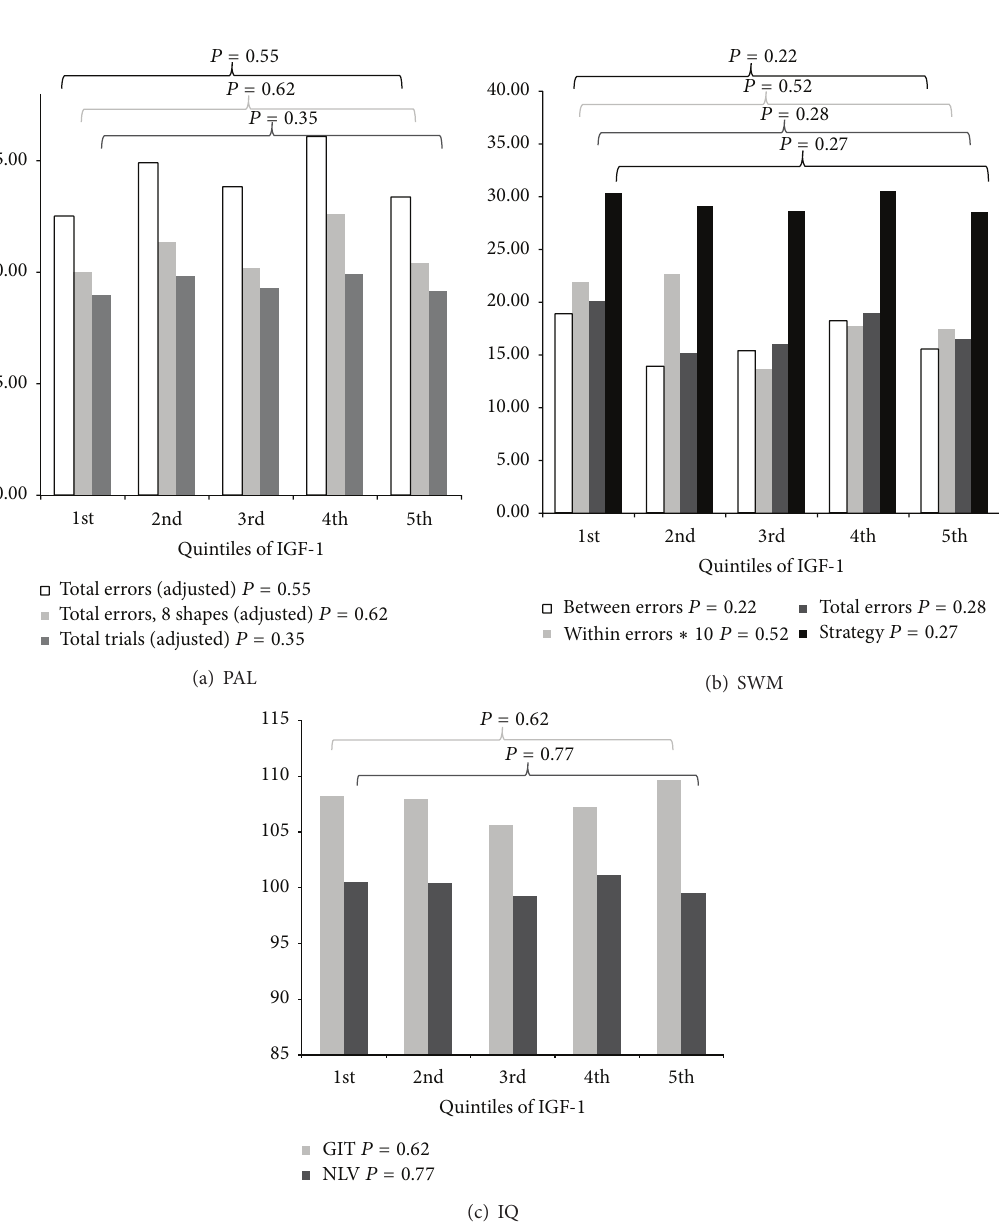
suggesting that the amount of IGF-1 receptors in a brain region does not play a role in the association between IGF- 1 level and cognitive performance in healthy